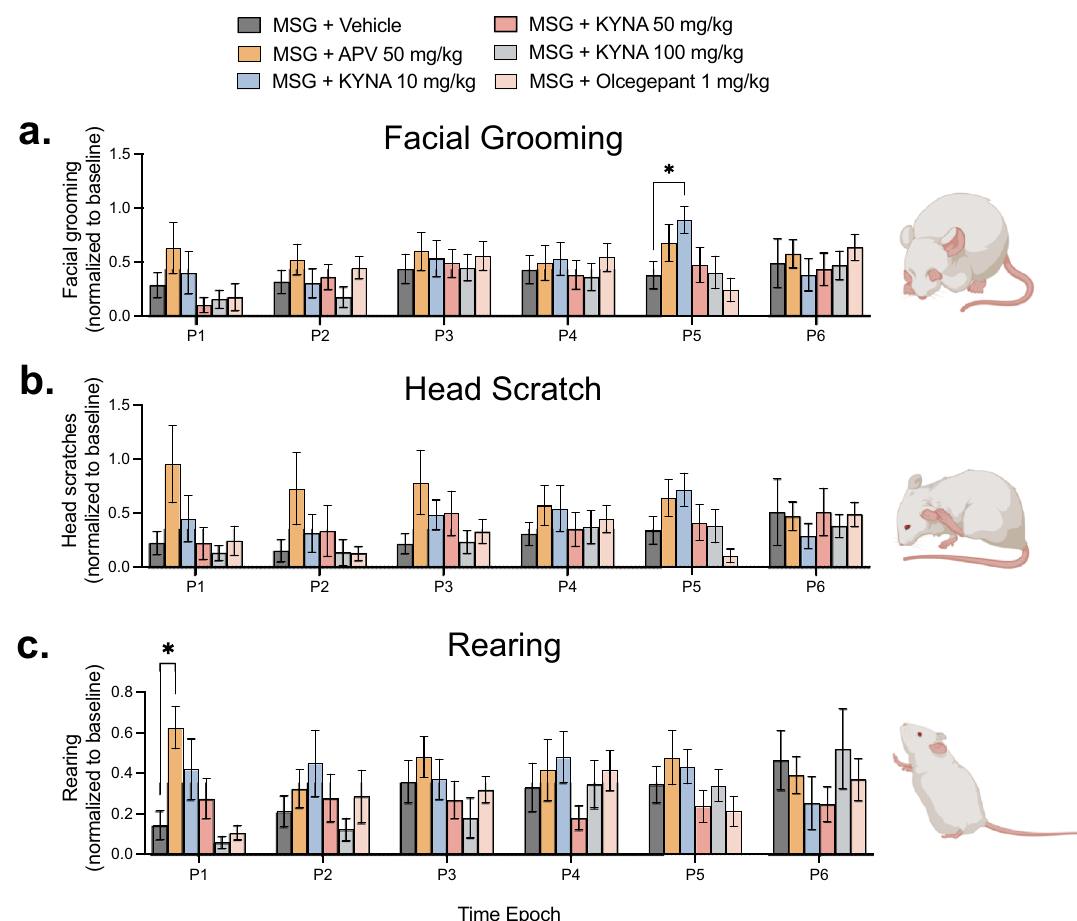
Figure 2. APV, KYNA and Olcegepant had no effect on MSG-induced suppression of normal exploratory and grooming behaviours. Comparison of the effect of MSG (1000 mg/kg; i.p.) alone with APV (50 mg/kg; i.p.), KYNA (10, 50, 100 mg/kg; i.p.) and olcegepant (1 mg/kg; i.p.) in combination with MSG (1000 mg/kg; i.p.) on ( a ) Facial grooming ( b ) Head scratch and ( c ) Rearing behaviours. Treatments had little effect on MSG-induced suppression of normal exploratory and grooming behaviours. The suppression of facial grooming was only significantly attenuated by KYNA (10 mg/kg) at P5. The suppression of rearing behaviour was significantly attenuated by APV at P1. Data are mean ± SEM (n = 12). Repeated measures two-way ANOVA and Dunnett’s test. Time Epoch = P1 (0–10 min), P2 (10–20 min), P3 (20–30 min), P4 (30–40 min), P5 (40–50 min) and P6 (50–60 min) post injection. (Created with personal license of